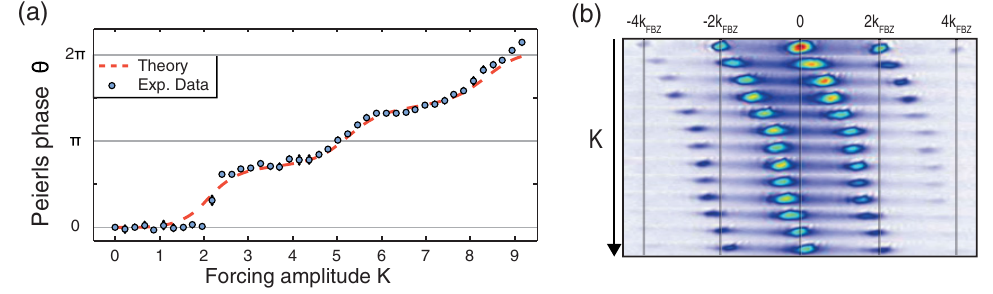
Figure 2. Creation of complex tunneling matrix elements. (a) The measured Peierls phases in a 1D driven optical lattice for different values of the forcing amplitude K are depicted as circles. The dashed red curve corresponds to the theoretically expected values (equation (3)). (b) Quasimomentum distribution of the BEC after 27ms time-of- flight for different values of K . The Peierls phase as a function of K is deduced from the observed shifts of the interference